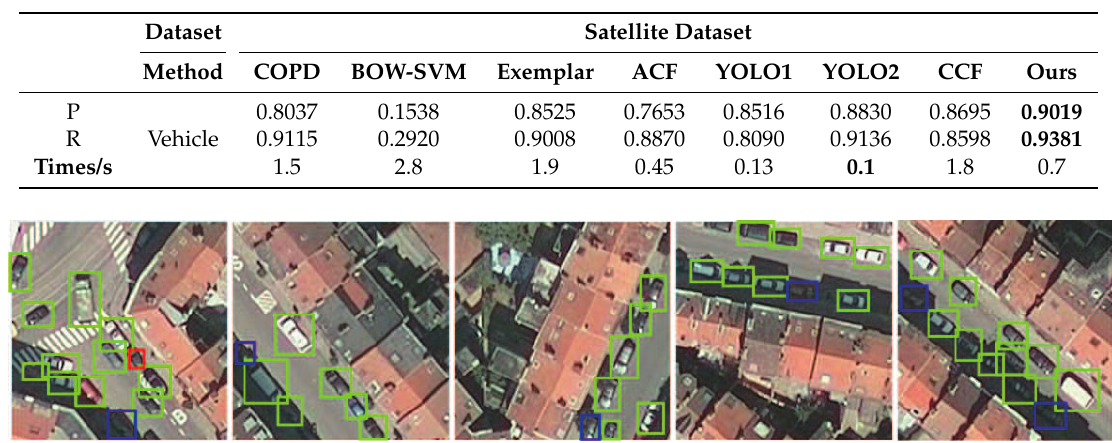
Table 7. Quantitative performance comparisons and running time with the satellite dataset. The optimal value is shown in bold.